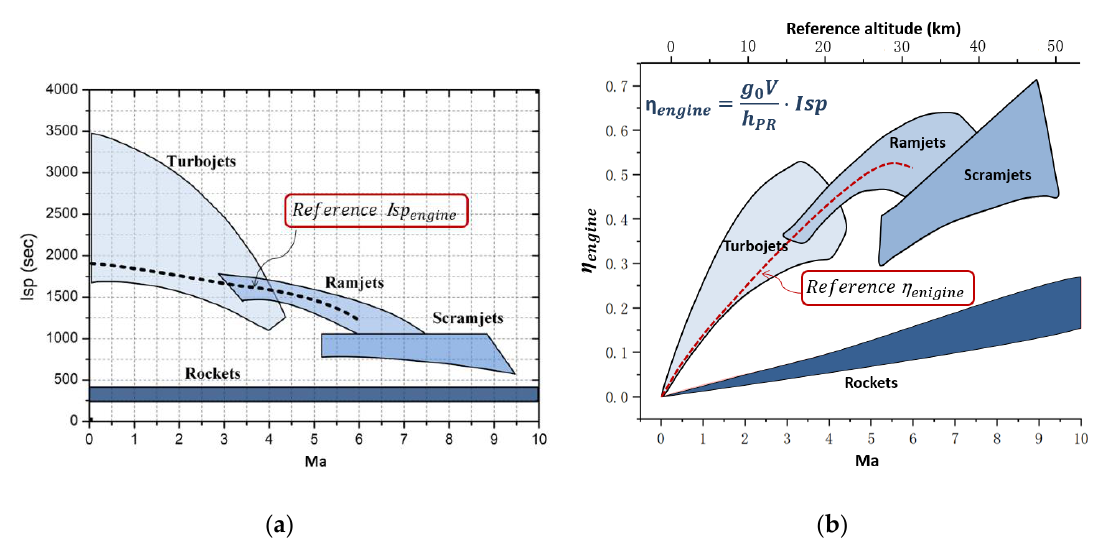
Figure 2. ( a ) Reference Isp of engines; ( b ) Reference efficiency of engines.